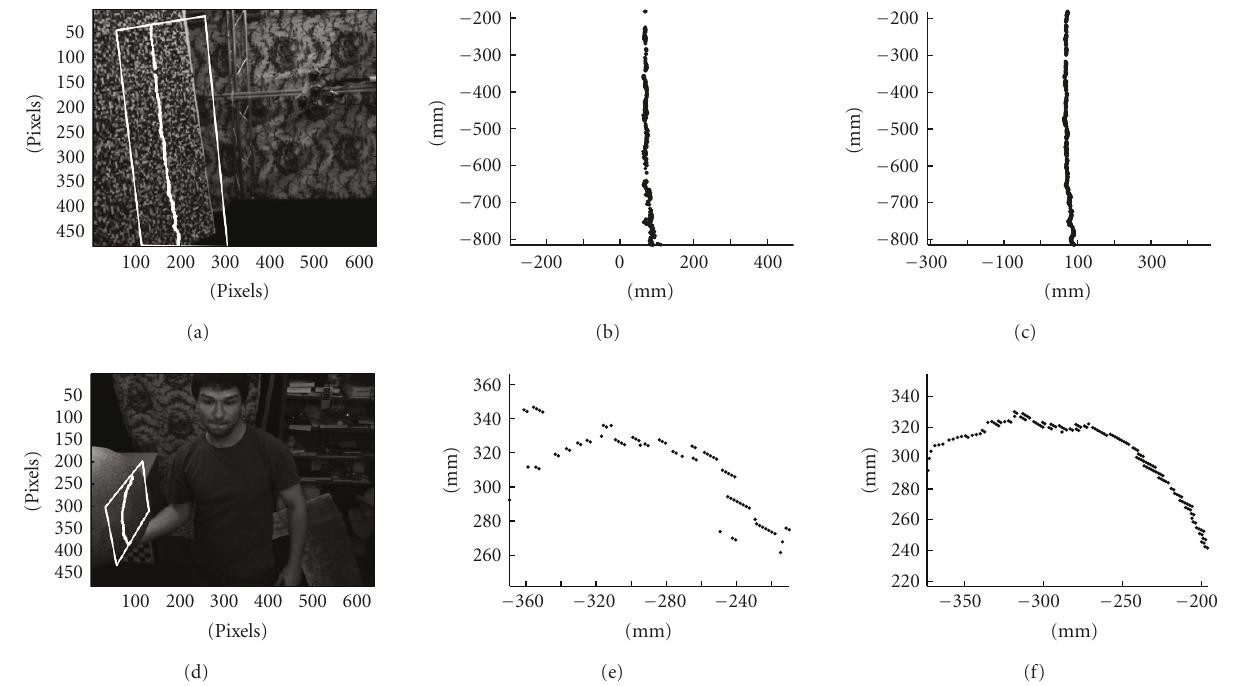
Figure 3: Comparison of planar and spherical backprojection surfaces in space sweeping. Each row shows an image from a binocular pair and sections of the obtained reconstructions for planar (center) and spherical (right) backprojection surfaces. In the experiment, τ = · 7, FOV = π/ 4, π/ 4, tessellation of d i was 2 mm and regular. The stereoscopic image pair was obtained from a 156 mm-baseline camera pair. The images were fully calibrated images and rectified for lens